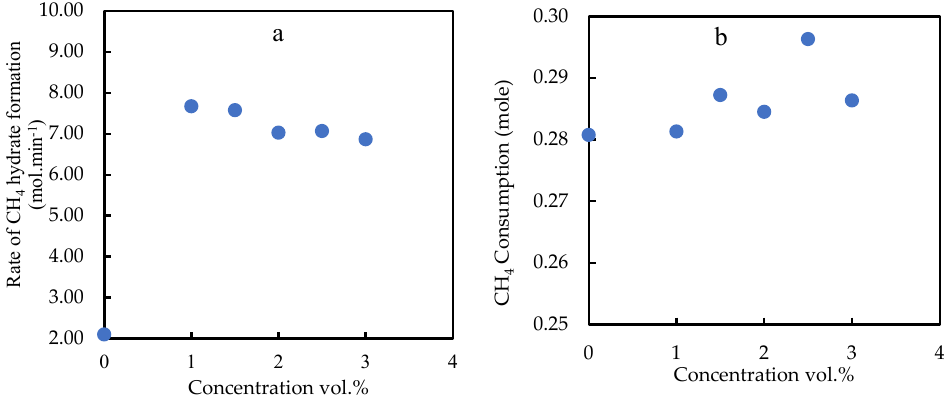
Figure 10. The effect of concentration of nonionic surfactant on: ( a ) rate of hydrate formation and ( b ) degree of gas consumption.